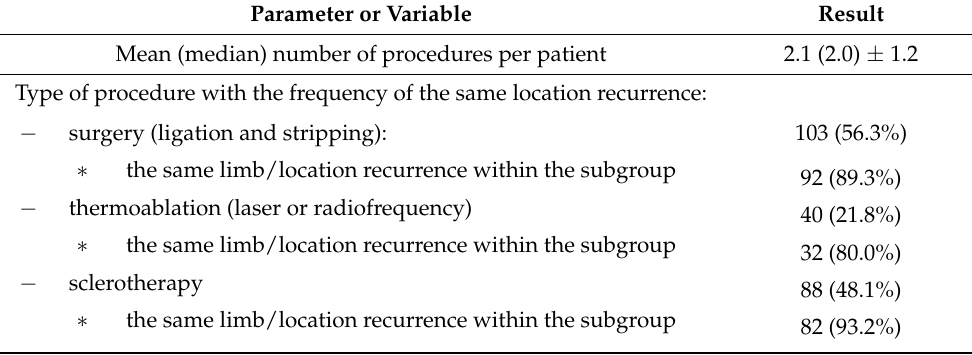
Table 2. Characteristics of the “Recurrence” group. The values shown in the table represent the mean (median) ± SD, or the number (percent) of patients in the group, respectively. Parameter or Variable Result Mean (median) number of procedures per patient 2.1 (2.0) ± 1.2 Type of procedure with the frequency of the same location recurrence: